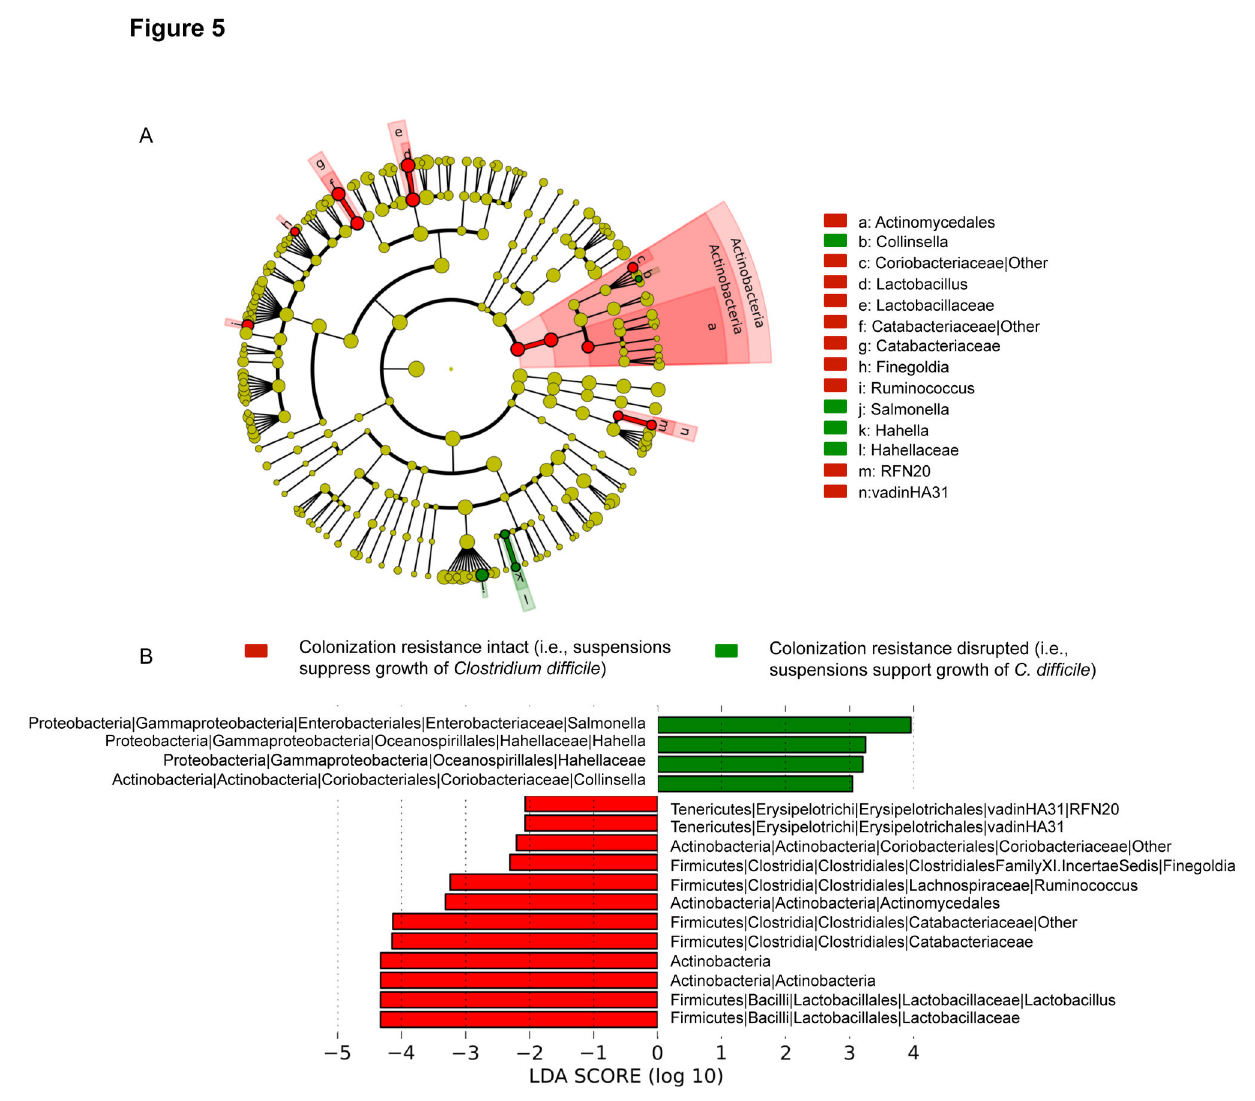
Figure 5. Microbiota signature of bacteria associated with intact versus disrupted colonization resistance to Clostridium difficile . (A) Phylogenetic tree display of the bacteria identified from stool samples of 8 vancomycin-treated patients with intact (i.e., C. difficile growth suppressed) or disrupted (i.e., C. difficile growth supported) colonization resistance based on the in vitro colonization assay. Clades of bacteria that significantly support or suppress C. difficile growth are highlighted in green or red, respectively. Circle diameter at each phylogenetic level is proportional to the corresponding taxon’s abundance. (B) Histogram of the Linear Discriminant Analysis (LDA) score of key bacteria abundance in suppressive and supportive groups arranged according to their effect size. Positive (green bars) and negative (red bars) LDA scores represent supportive and suppressive bacteria,